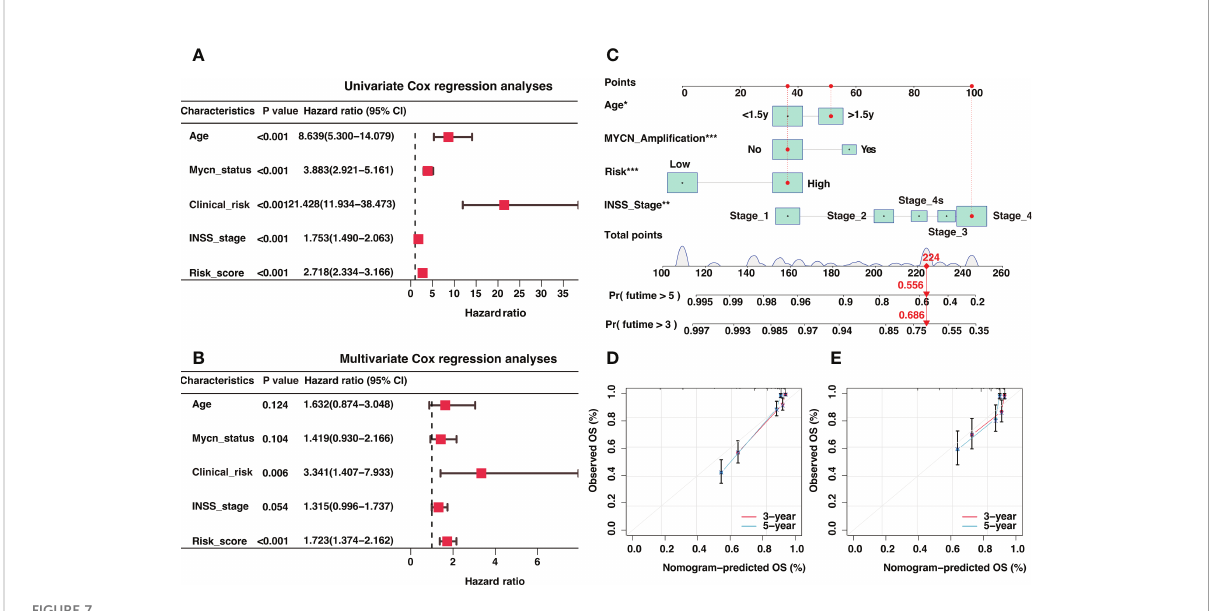
FIGURE 7 Independent prognosis analysis of the risk signature and construction of a nomogram for 3-year and 5-year overall survival (OS) prediction. (A) The univariate Cox regression analysis in GSE49710 cohort (B) . The multivariate Cox regression analysis in GSE49710 cohort. (C) The establishment of a nomogram that predicted 3-year and 5-year OS in the GSE49710 cohort. (D, E) Calibration curves of the nomogram in the prediction of 3-year and 5- year OS in GSE49710 (D) and E-MTAB-8248 (E) cohorts. *: P < 0.05, **: P < 0.01, ***: P <